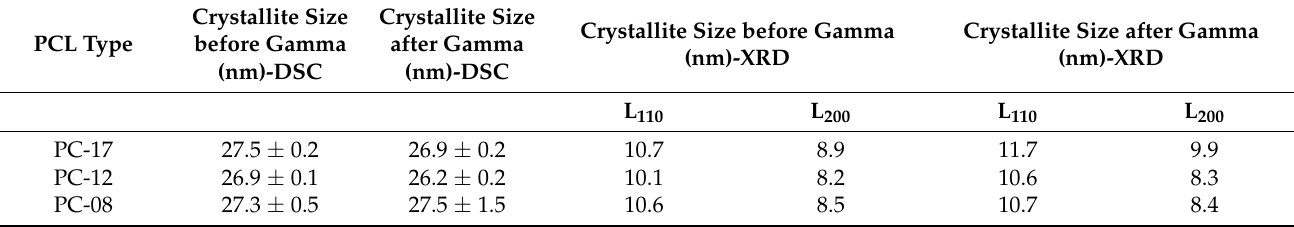
Figure 3. Exemplary graphs of ( a ) DSC heat flow curves and ( b ) XRD profiles of PCL tubes comprising PC-17, PC-12, and PC-08 with 100 µ m wall thickness and 2.5 mm OD. Table 2. Thermal properties of PCL tubes from XRD and DSC